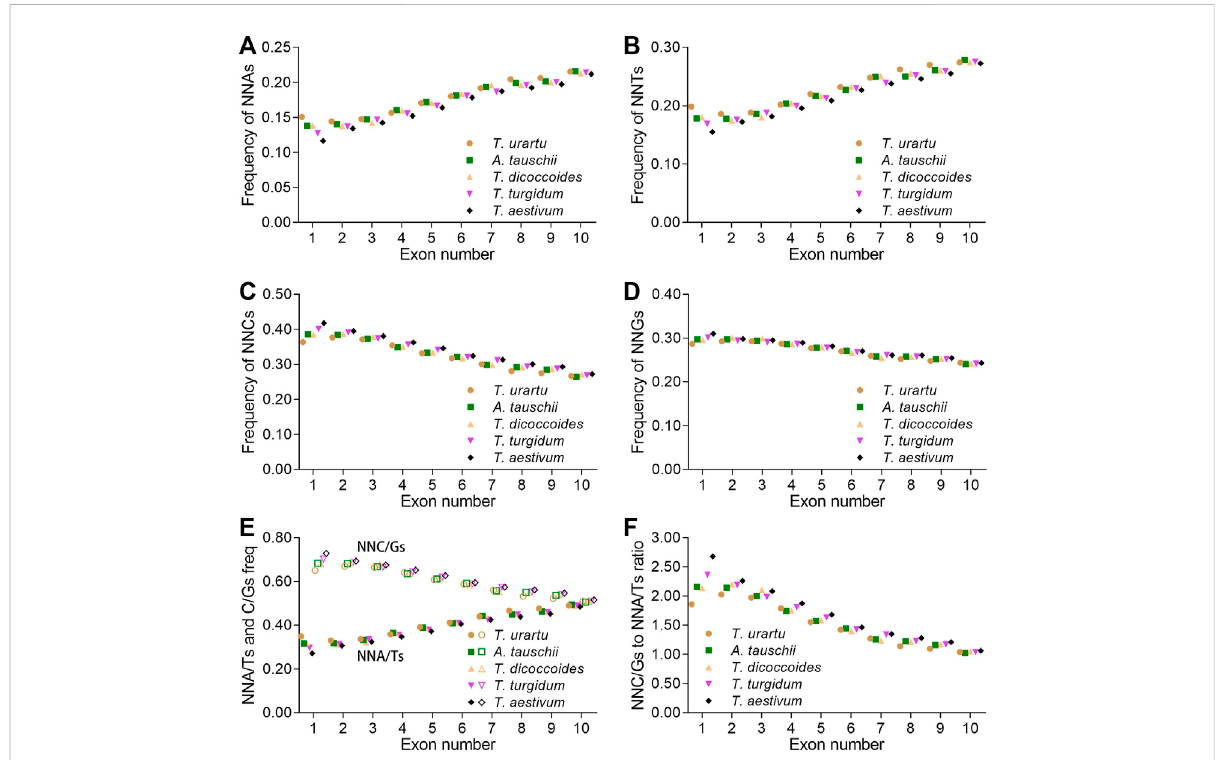
FIGURE 2 In fl uence of the number of introns on SCUB. Frequencies of A-ending SCs (NNAs) (A) , T-ending SCs (NNTs) (B) , C-ending SCs (NNCs) (C) , G-endingSCs(NNGs) (D) ,orA/T-andC/G-endingSCs(NNA/TsandNNC/Gs) (E) ingeneswithuptonineintrons. (F) RatiosbetweenA/T-endingSCs and C/G-ending SCs (NNA/Ts and NNC/Gs) in genes with up to nine introns. N denotes any base. The difference between hexaploid wheat and its progenitors was calculated by Chi square ( χ 2 ) test, and the results are presented in Supplementary Table